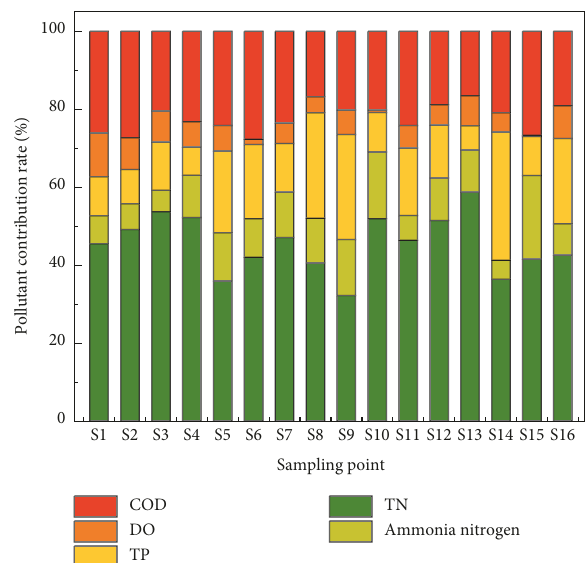
Figure 8: The contribution rate of pollutants at each sampling point for the comprehensive pollution index